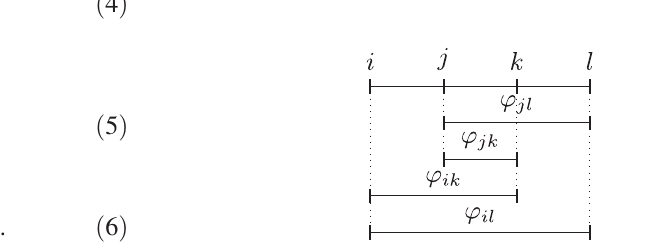
FIG. 1. The interval of BPMs with corresponding phase advances.